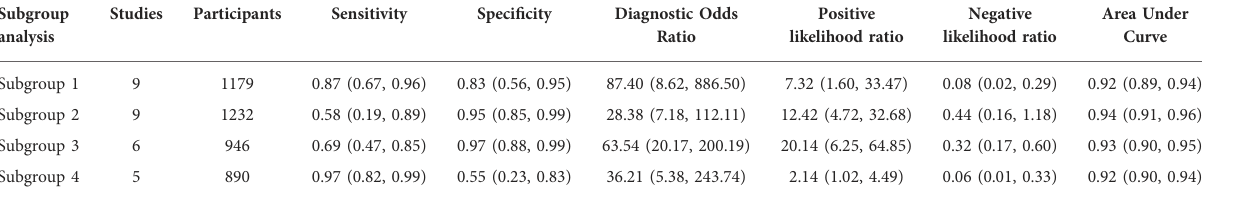
TABLE 4 Summarized diagnostic value of NBI for OPMD and OSCC within various subgroups.